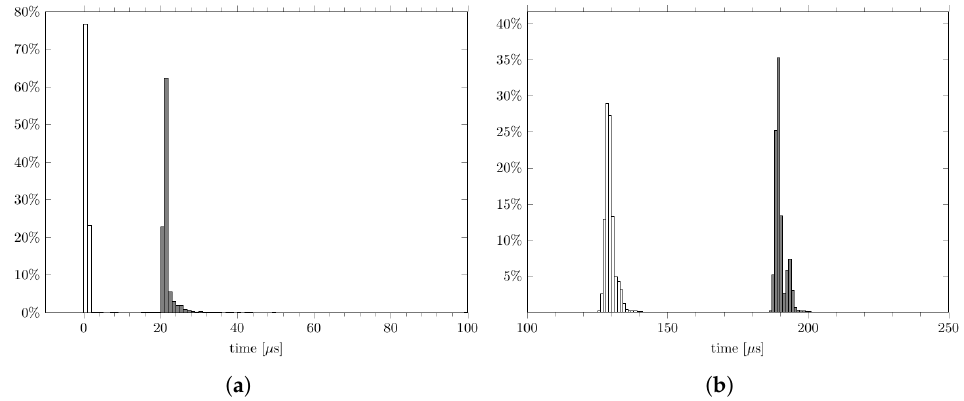
Figure 3. Cycle times: ( a ) the PID computation for the C++ (white) and Python (gray) applications without garbage collectors; ( b ) the real-time FFT computations for the C++ (white) and Python (gray) applications without garbage